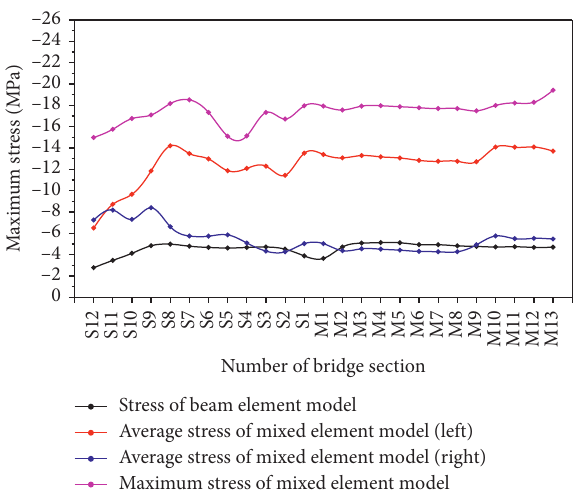
Figure 19: The calculated stress value of the top plate of the steel girder in both the beam element model and the mixed element model in summer.